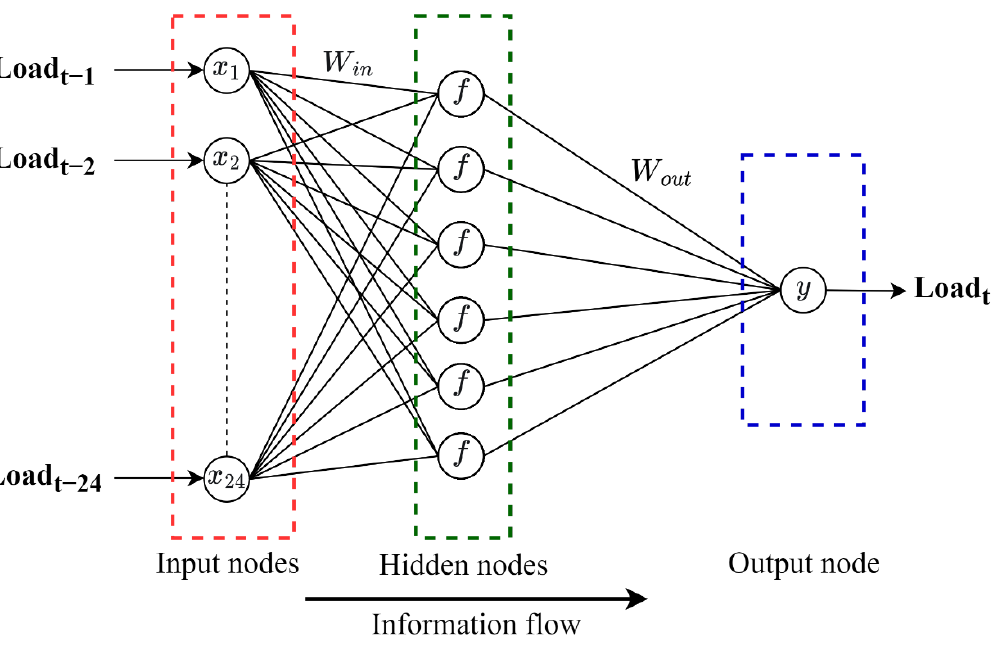
Figure 1. Structure of the feedforward ANN used in the